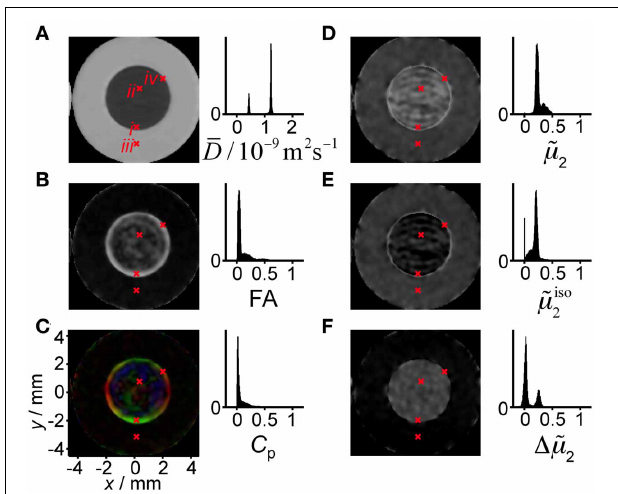
FIGURE 5 | Parameter maps and histograms for the liquid crystal/yeast phantom. The panels show (A) mean diffusivity D , (B) fractional anisotropy FA, (C) planar index C p , (D) scaled variance (cid:17) μ 2 , (E) scaled isotropic variance (cid:3) (cid:17) μ 2 . The red crosses, (cid:17) μ iso 2 , and (F) the difference in scaled variance numbered with roman numerals in panel (A) , point out pixels for which the acquired signal is shown in detail in Figure 6 . The colors in the C p map indicate the direction of the vector corresponding to the minimum eigenvalue of the diffusion tensor (red: x , green: y , blue: z ). Pixels with signal below a threshold value are shown in black in the parameter maps and excluded from the calculation of the